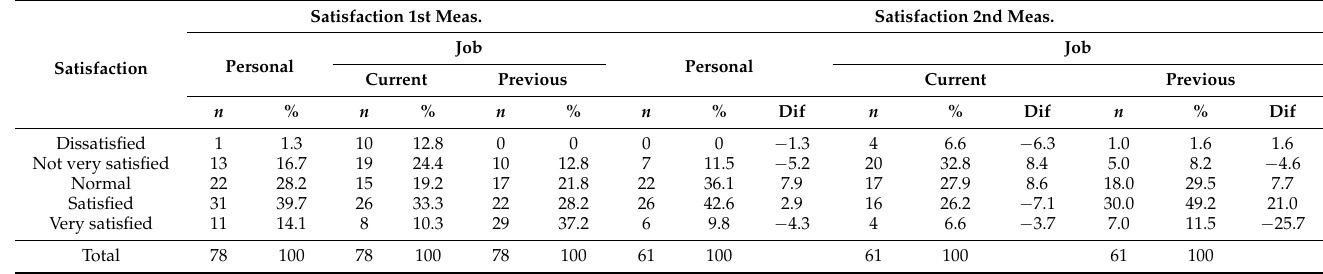
Table 9. Frequencies and differences in the satisfaction dimension in both measurements.